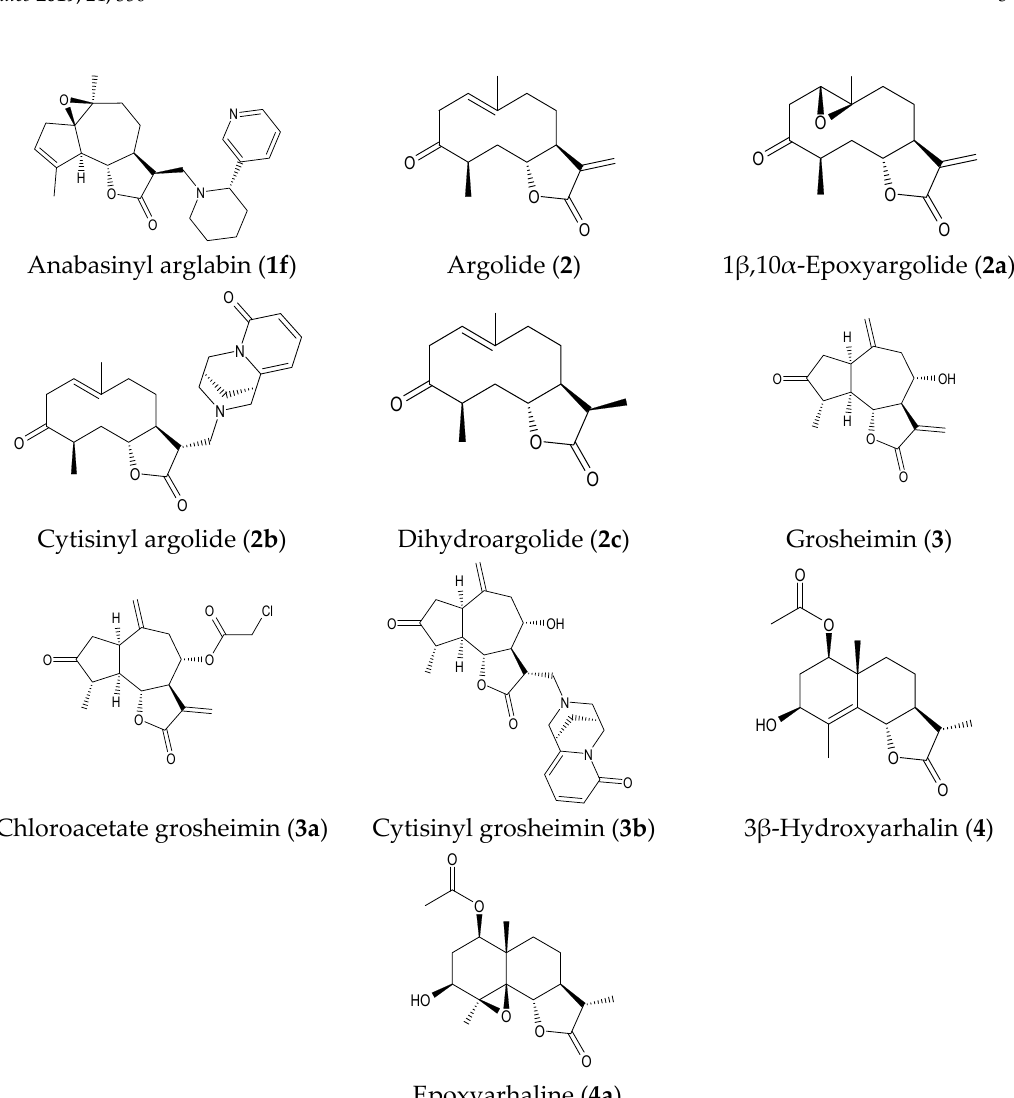
Figure 1. Chemical structures of natural sesquiterpene lactones (SLs) arglabin ( 1 ), argolide ( 2 ), dihydroargolide ( 2c ), grosheimin ( 3 ), 3 β -hydroxyarhalin ( 4 ), and their semi-synthetic derivatives 1a – f , 2a , b , 3a , b , 4a .